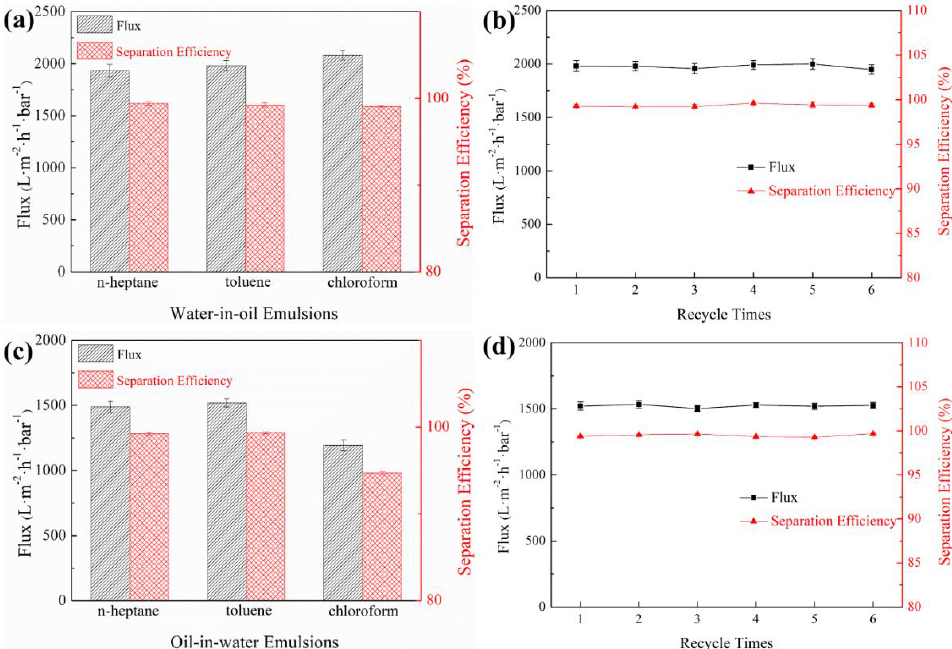
Figure 5. ( a ) Separation flux, the efficiency of different water-in-oil emulsions in as-prepared PDA/P- PVDF@PP Janus membrane; ( b ) the reusability of the PDA/P-PVDF@PP Janus membrane for the separation of the water-in-toluene emulsion; ( c ) separation flux, the efficiency of different oil-in-water emulsions in as-prepared PDA/P-PVDF@PP Janus membrane; ( d ) the reusability of the PDA/P- PVDF@PP Janus membrane for the separation of the toluene-in-water